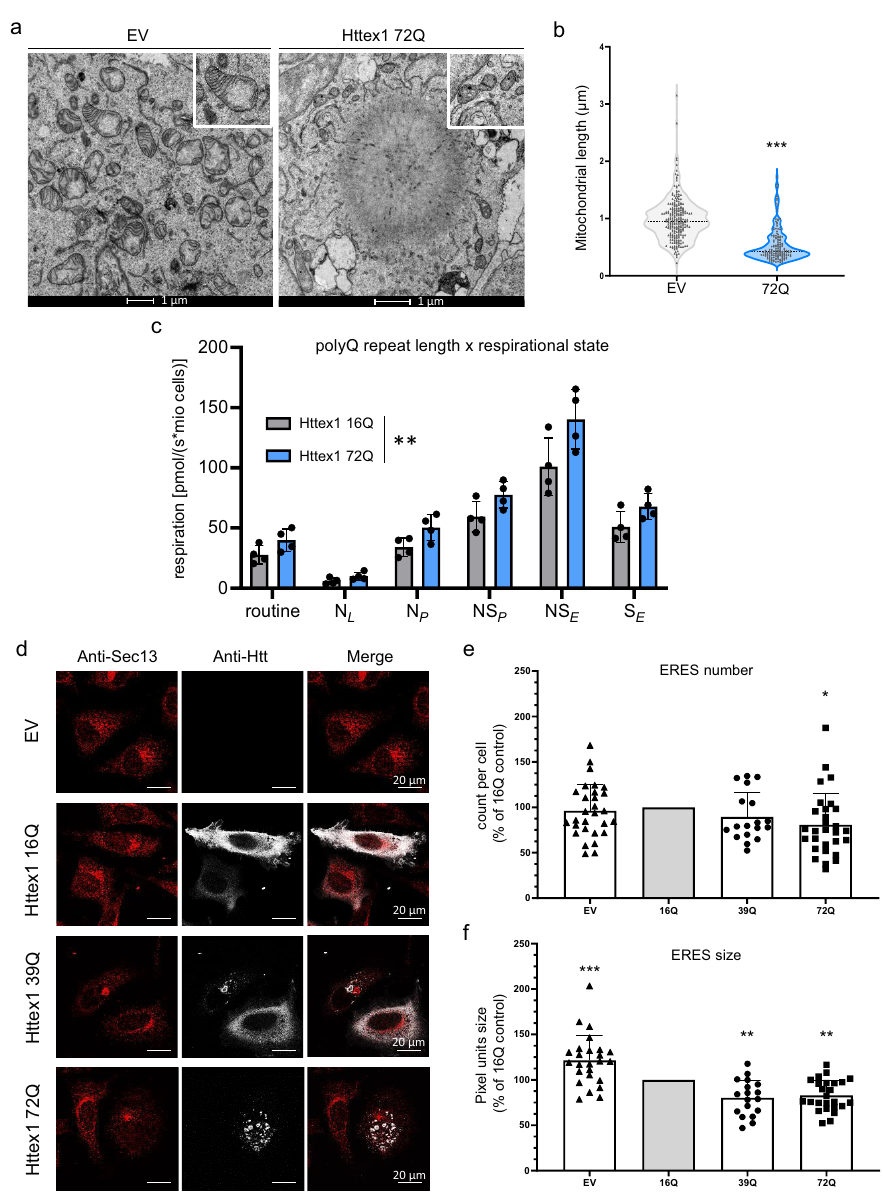
Fig. 4 Formation of Httex1 72Q inclusions induces mitochondrial alterations and the reduction of ER-exit sites. a Electron micrographs of mitochondria in HEK cells overexpressing empty vector (EV) or Httex1 72Q. The insets depict higher magni fi cation of the mitochondria found at the periphery of the Httex1 72Q inclusions or in EV controls. Scale bars = 1 μ m. b Measurement of the mitochondrial length with FIJI reveals a signi fi cant reduction in the size of the mitochondrial pro fi le located in the proximity of the inclusions. An unpaired t -test was performed (two-sided) resulting in a p -value of 0.0006. An unpaired t-test was performed (two-sided) resulting in a p -value of 0.0006. c HEK cells from 4 independent experiments were gently detached for high- resolution respirometry (HRR) 48 h after transfection with indicated constructs. HRR was performed in respiration media. After the measurements of routine respiration, cells were permeabilized by digitonin, and different respirational states were subsequently induced using a substrate-uncoupler- inhibitor titration (SUIT) protocol. Routine respiration, NADH-driven, or complex 1-linked respiration after the addition of ADP (OXPHOS state) (NP), NADH- and succinate driven, or complex 1 and 2-linked respiration in the OXPHOS state (NSP), and in the uncoupled electron transport system (ETS) capacity (NSE), as well as succinate driven, or complex 2-linked respiration in the ETS state (SE) were assessed. The graphs represent the mean ± SD of 4 independent experiments. Two-way ANOVA showing a signi fi cant interaction between the respirational states and the polyQ repeat length ( p - value = 0.004). d Representative confocal images of HeLa cells transfected with Httex1 16Q, 39Q, or 72Q or EV. Cells were fi xed 48 h after transfection and immunostained. Httex1 was detected with the MAB5492 Htt antibody (grey), and ER exit sites (ERES) were detected with Sec13 (red). Scale bars = 20 μ m. e , f ERES number ( e ) and size ( f ) quanti fi cations from confocal imaging were performed using FIJI. The graphs represent the mean ± SD of 3 independent experiments represented as a relative percentage to Httex1 16Q control. One-way ANOVA followed by a Tukey honest signi fi cant difference [HSD] post hoc test was performed ( p -values < 0.0001 for panels e and f). * P < 0.05, ** P < 0.005, *** P < 0.001 for multiple